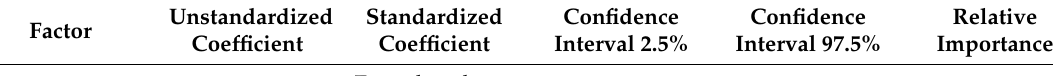
Table A2. Model averaged estimates (coefficients) of variables that explain the fern species abundance, richness, and composition among forest fragments. The factor included as dependent variables are DBH (number of trees > 10 cm), canopy closure, basal area, soil PCA1, soil PCA2, AWC, slope, elevation, aspect, fragment size. Model averaged estimates (unstandardized and standardized coefficients), confidence intervals (CIs), and relative importance (RI) values are shown for all variables. NA = Not applicable; variable not in the models with ∆ AICc < 4.0.